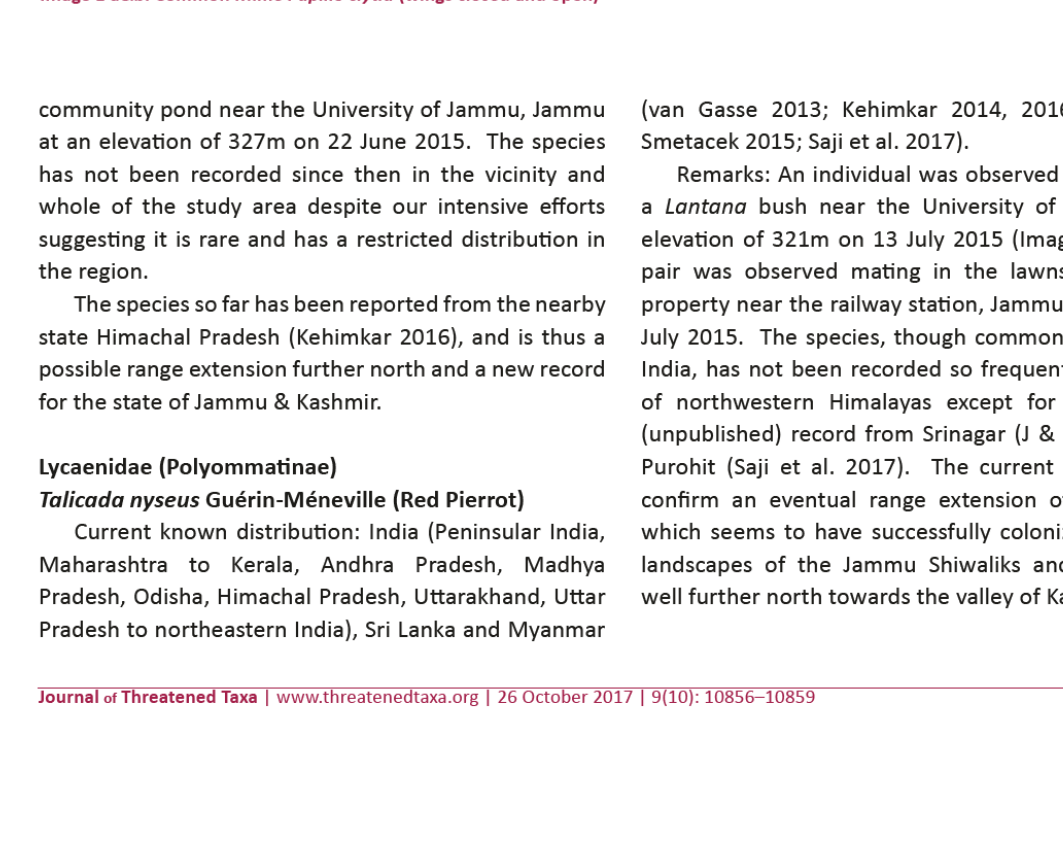
Ffigure 1. Map of the study area showfing locafions of